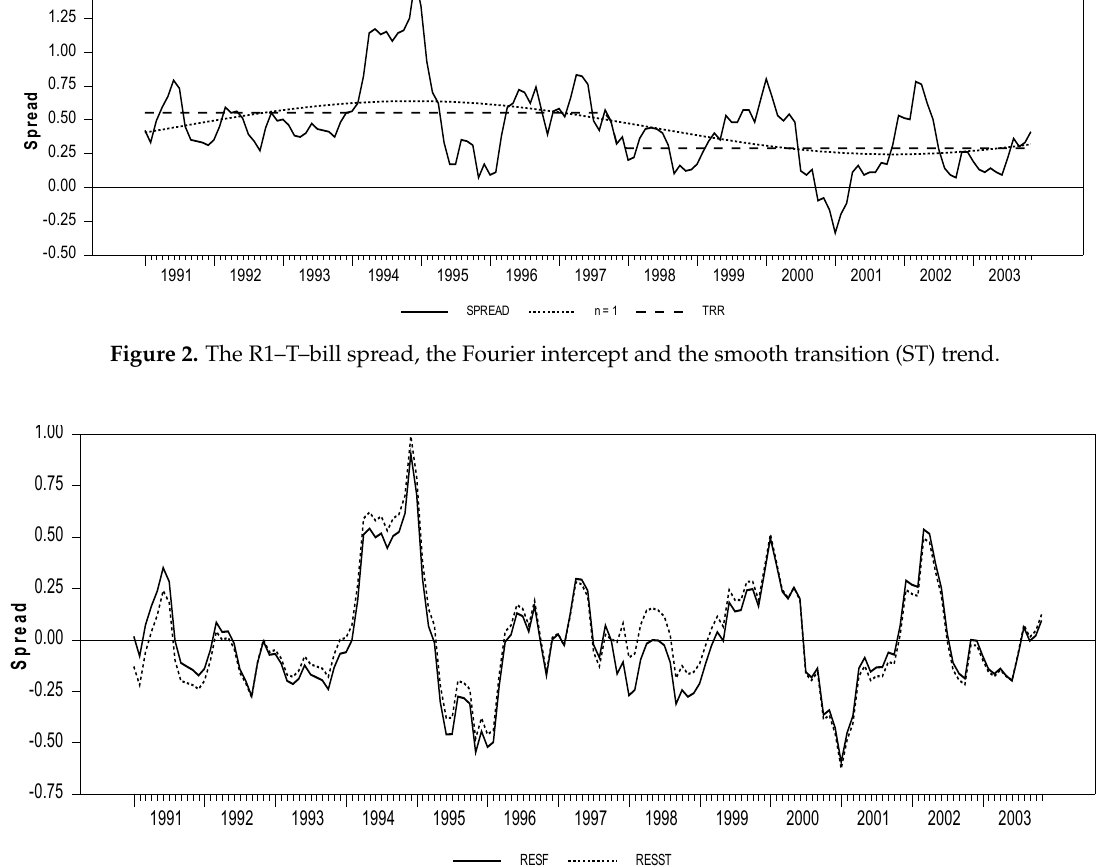
Figure 3. Residual from de–trending with Fourier intercept and the ST trend.